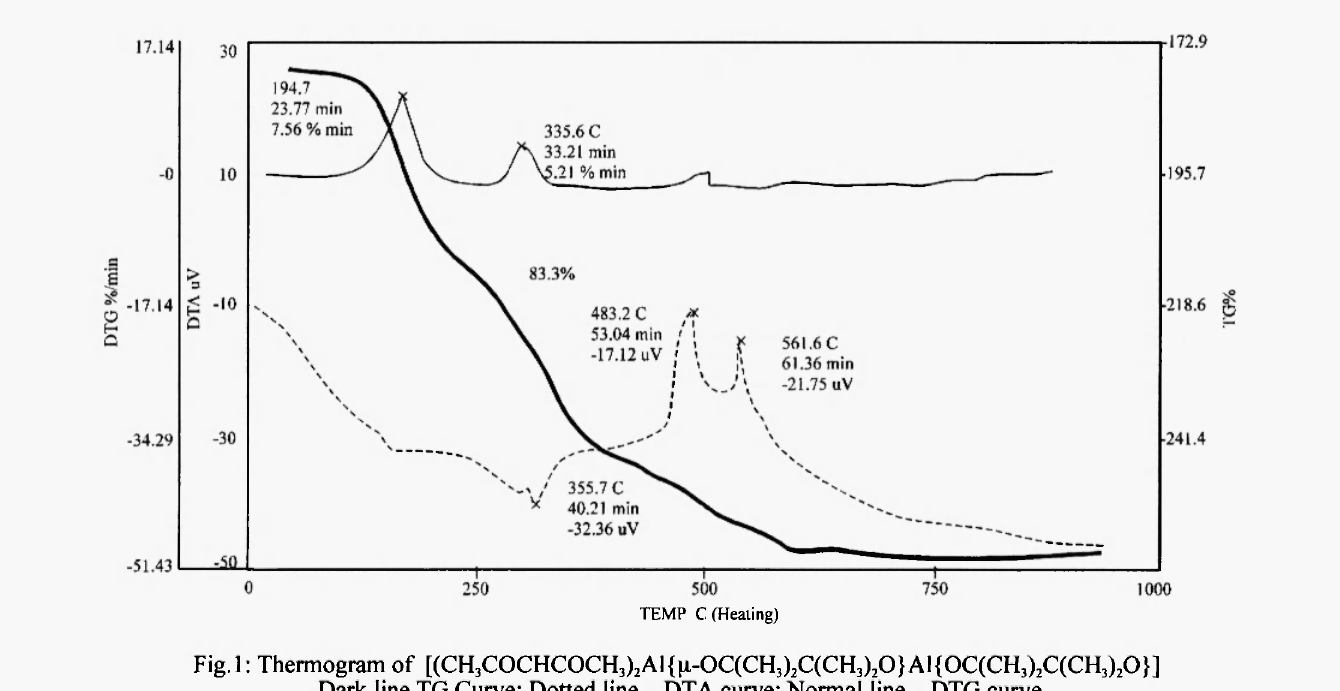
TABLE- III: 'H NMR spectral data (δ ppm) of [CH3C0CHC0CH 3 )2Al^-0 -G -0)Al(0 -G